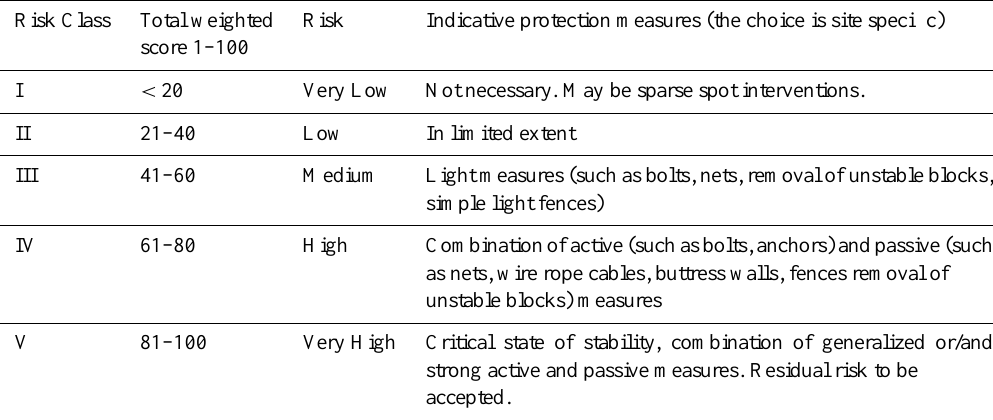
Table 5. Rockfall risk classes and indicative protection measures Risk Class Total weighted Risk Indicative protection measures (the choice is site